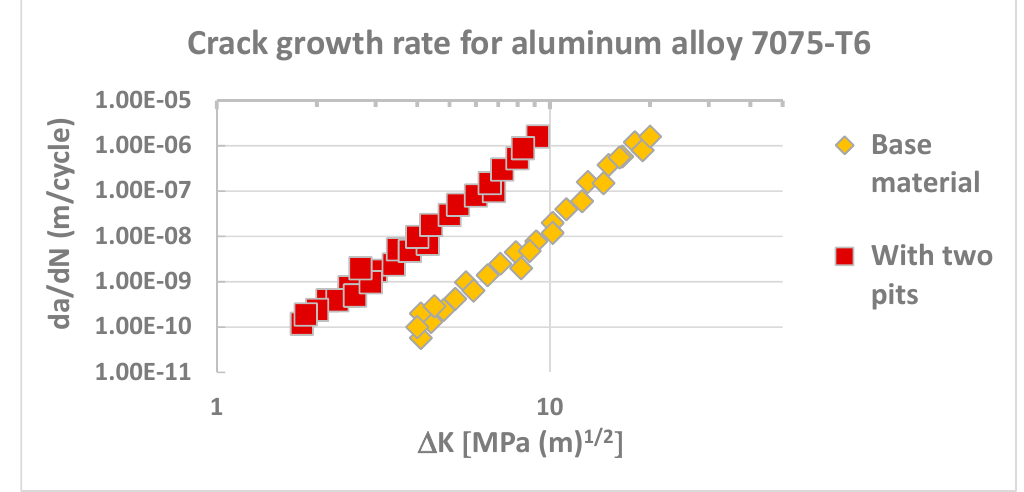
Figure 19. Crack growth rate for the base material and specimens with two pits, under ultrasonic fatigue tests.